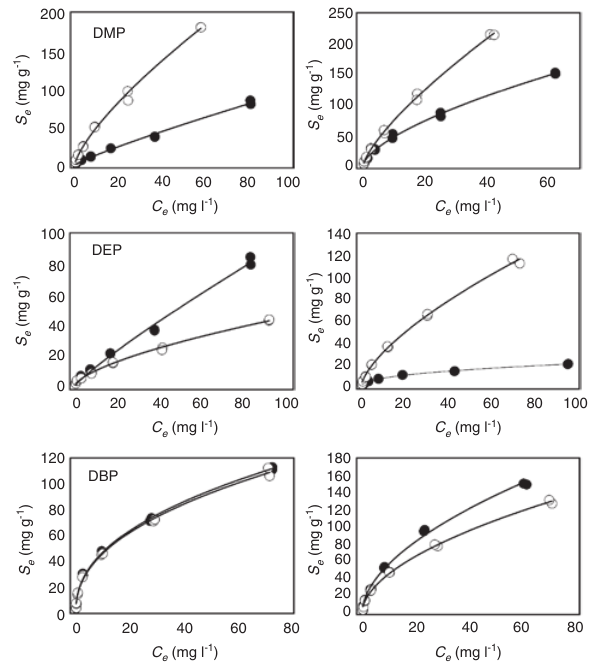
Figure 5: Adsorption of dimethyl phthalate (DMP), diethyl phtha- late (DEP) and dibutyl phthalate (DBP) on biochars and oxidized biochars, as a function of temperature (original on left and oxidized biochars on right hand). Open and closed symbols ( ○ , ● ) represent 300 ° C and 500 ° C biochars,